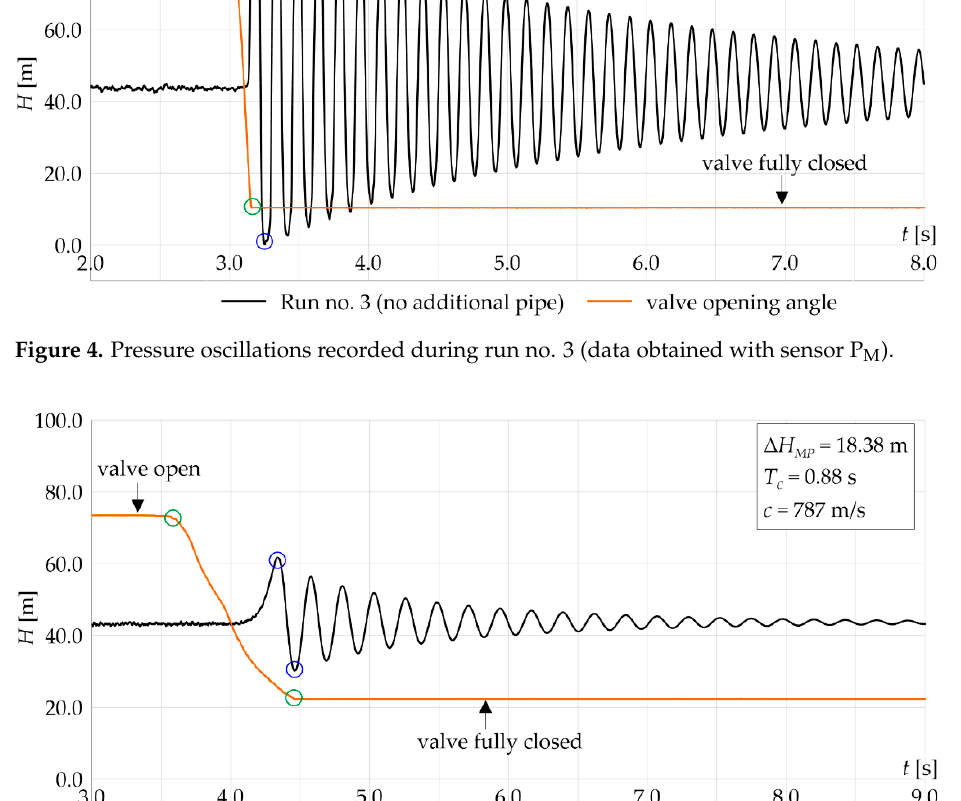
Figure 5. Pressure oscillations recorded during run no. 5 (data obtained with sensor P M ). As shown in Figure 4, the maximum pressure increase in the MP without AP installed was equal to 50.84 m. The orange plot in Figures 4 and 5 represents the valve opening angle and does not correspond to values of pressure head in the vertical axis. In order to determine the time of valve closure which initiated the water hammer phenomenon, the time difference between the start and the end of valve closing was read (marked with green circles in Figures 4 and 5). Experimentally obtained pressure oscillations are a harmonic function with a period equal to the pipeline period of the reflection time. To determine pressure wave speed, the time difference between minimum and maximum pressure was considered (marked with blue circles in Figures 4 and 5). The main characteristics of all experimental runs are reported in Table 2. Table 2. Data from experimental runs.